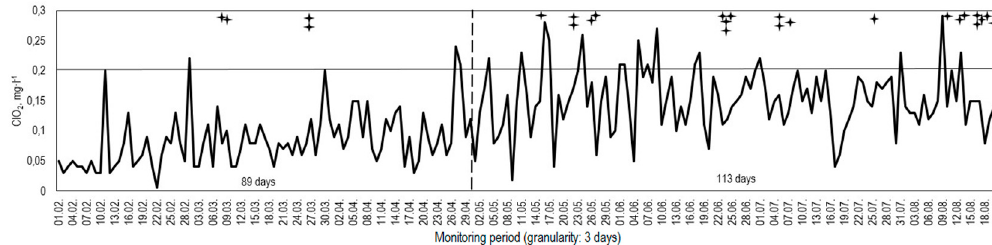
Figure 2. Chlorine dioxide (ClO 2 ) concentration and crayfish mortalities during the monitoring period. The stars indicate crayfish mortalities; the fluctuating line indicates levels of ClO 2 concentration; the solid horizontal line indicates level of ClO 2 concentration 0.2 mg L − 1 ; the punctuated vertical line divides exposure period in two parts: First period (89 days), when high ClO 2 concentrations (up to 0.2 mg L − 1 ) were found five times and four crayfish died; and the second period (113 days), when high ClO 2 concentrations occurred 23 times and 21 crayfish